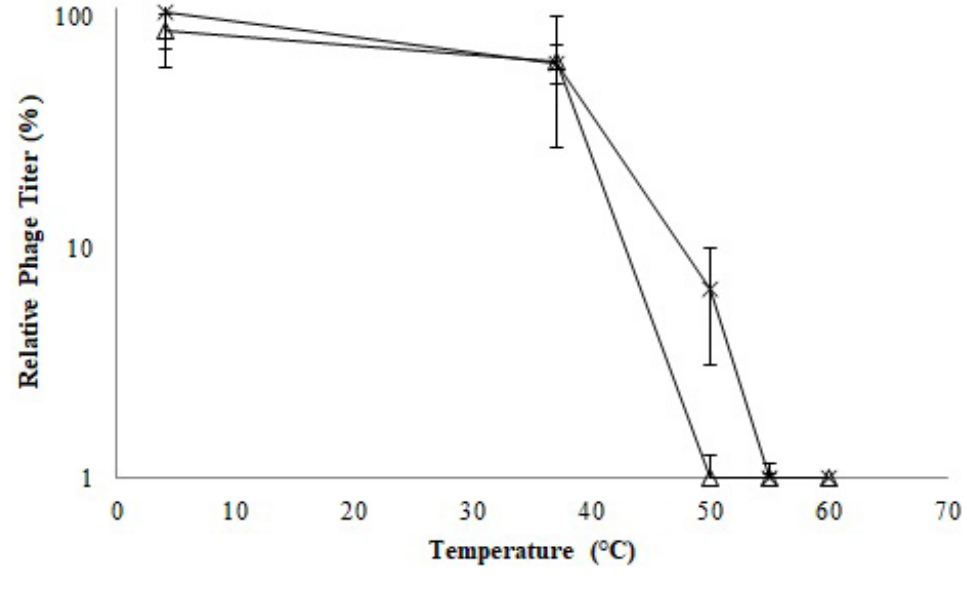
Figure 4: Influence of temperature on stability of the B . cereus bacteriophages BaceFT01 (Δ) and BaceCM02